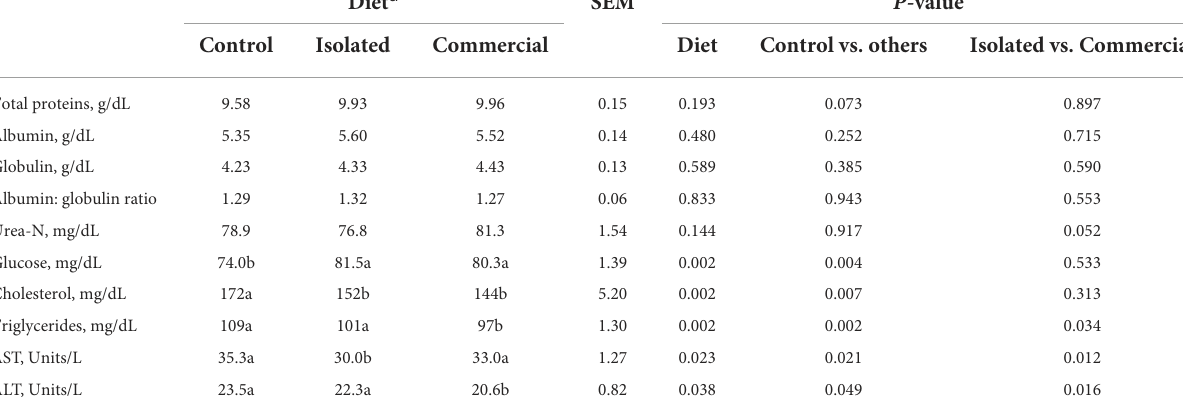
TABLE 4 Experiment 2: Blood parameters of Holstein cows fed diets supplemented with isolated or commercial E. faecium as probiotics. Diet a SEM P -value Control Isolated Commercial Diet Control vs. others Isolated vs.